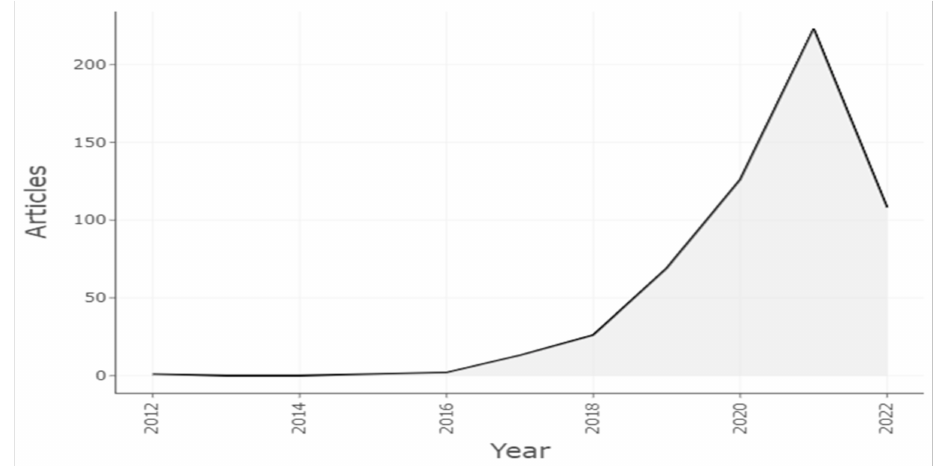
Figure 6. Annual scientific production.